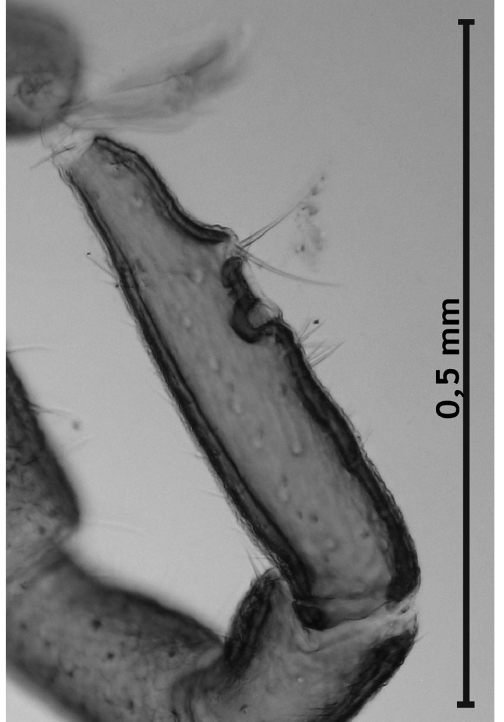
Fig. 7. – Tarsus of the leg I.